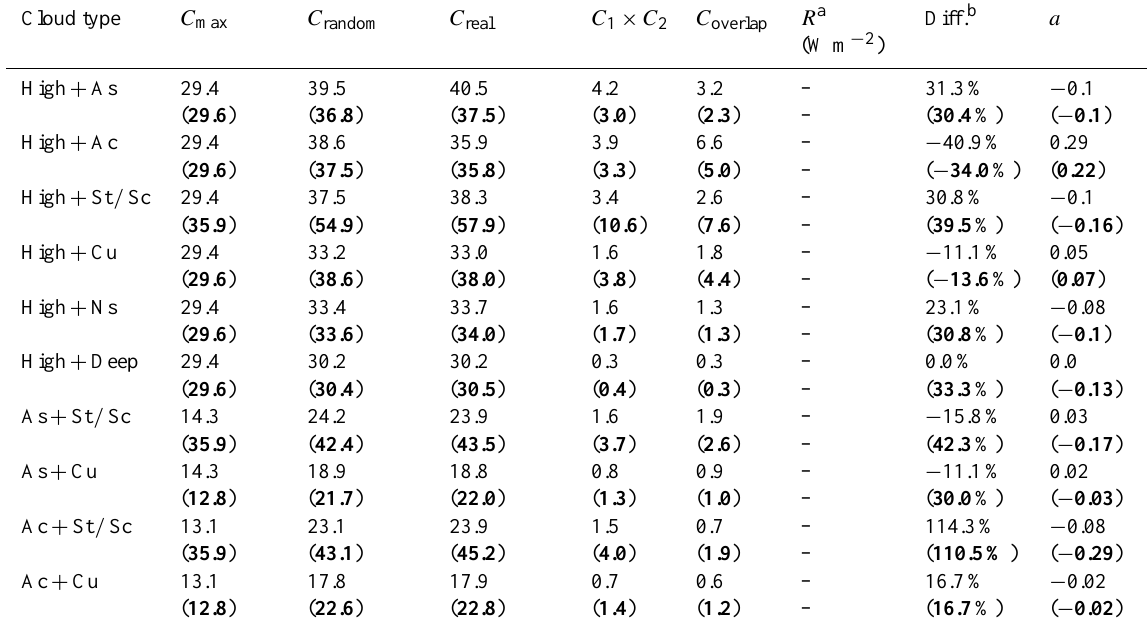
Table 4. Cloud fractions of different multilayered cloud types based on different overlap assumptions and observations during nighttime. Here, C overlap and C 1 × C 2 are the overlap cloud fractions from observations and overlap assumptions. “ a ” presents the overlap parameter. Cloud type C max